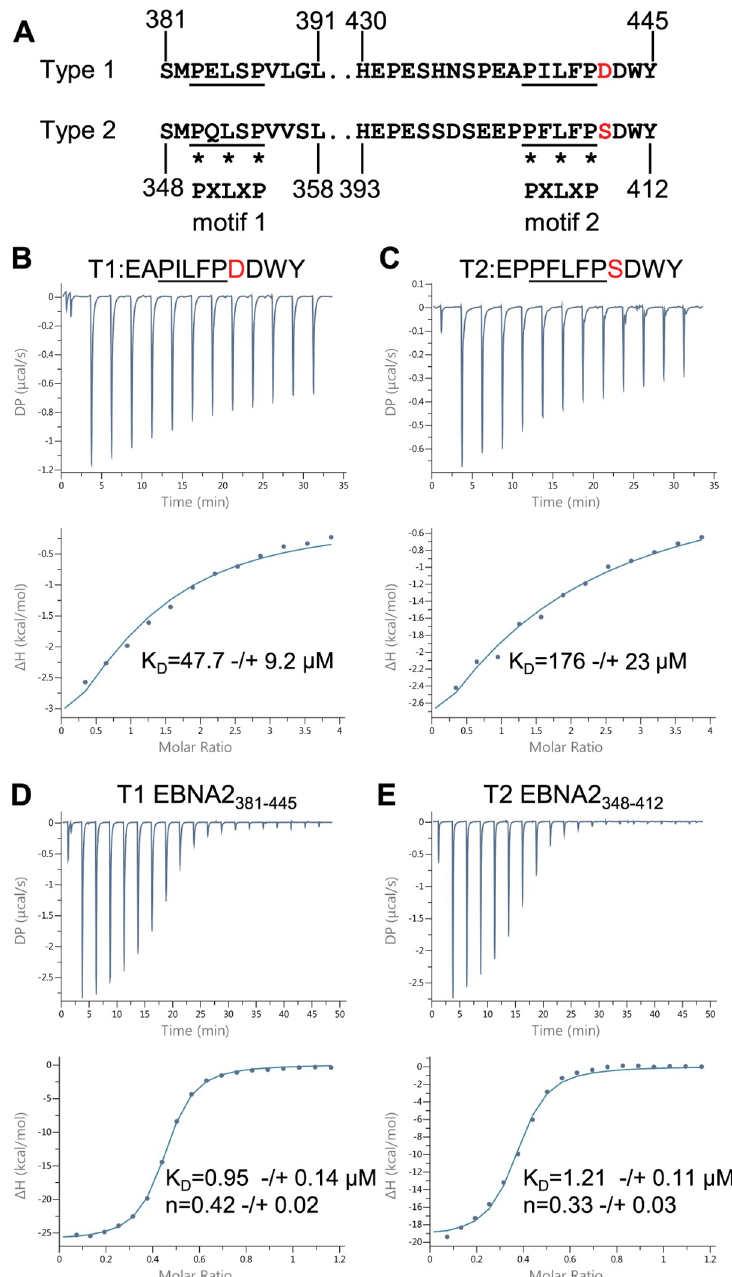
Fig 1. Isothermal titration calorimetry analysis of the interaction of type 1 and type 2 EBNA2 peptides and polypeptides containing BS69 binding motif 2 with BS69 CC-MYND . (A) Amino acid sequence of the regions of type 1 (B95-8) and type 2 (AG876) EBNA2 containing BS69 binding motifs 1 and 2 (underlined). Asterisks show the positions of the P, L and P amino acids in the PXLXP binding motif. Aspartate 442 in type 1 EBNA2 and the corresponding serine 409 in type 2 EBNA2 adjacent to motif 2 are shown in red. (B) Isothermal titration calorimetry (ITC) analysis of type 1 EBNA2 motif 2 peptide binding to BS69 CC-MYND . For all ITC experiments, the upper panel shows heat peak data as Differential Power (DP) versus time and the lower panel shows Δ H (derived from integration of the heat peak intensities) plotted against the BS69 CC-MYND /EBNA2 molar ratio (based on monomer concentrations). Titrations were performed using a series of 13 2.0 μ l injections of 1 mM EBNA2 peptide and 0.1 mM BS69 CC-MYND in the cell. The solid line shows the best fit using a one-site (one event) binding model with the n value fixed to 1. The dissociation constant (K D ) displayed shows the mean ± standard deviation obtained from 3 independent experiments. (B) ITC analysis of type 2 EBNA2 motif 2 peptide binding to BS69 CC-MYND (D) ITC analysis of the binding of the